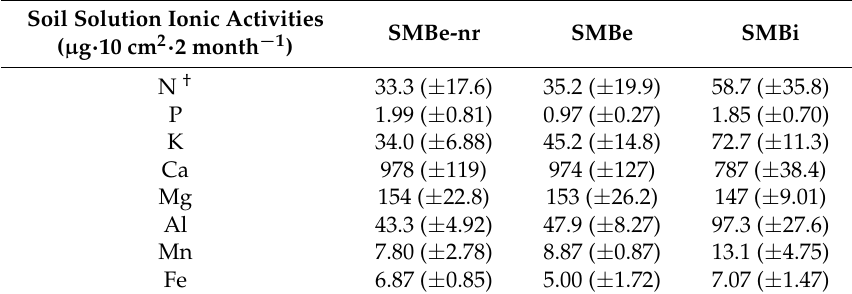
Table 4. Soil solution ionic activity at the base of the FH horizon as recorded by the PRS™ probes in the three forest types